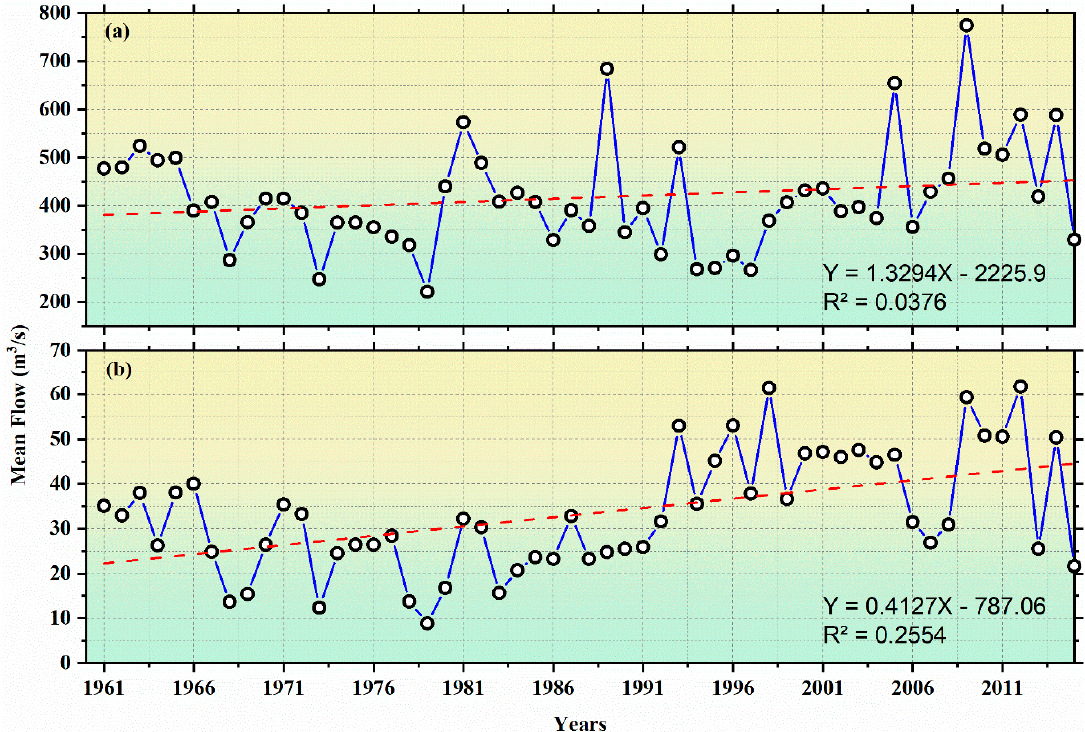
Figure 4. Annual streamflow linear trends for the Zhimenda ( a ), and Tuotuohe ( b ) stations during 1961–2015.